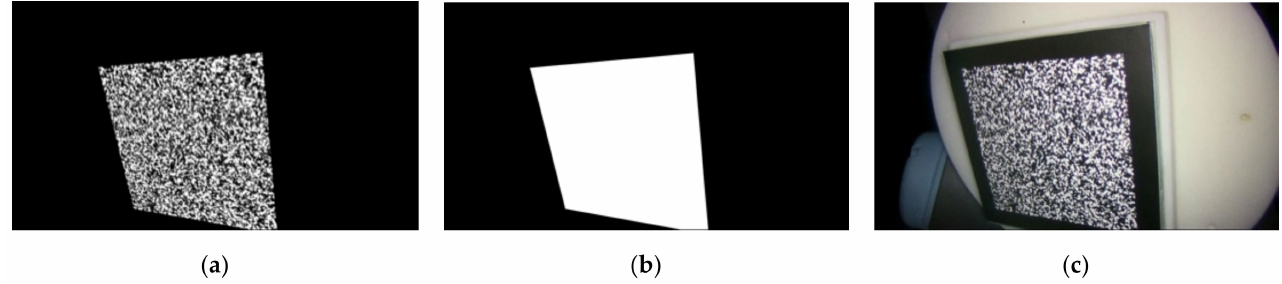
Figure 6. A group of images for DIC calculation in the second stage of our method, containing: ( a ) reprojection of reference image; ( b ) projection of mask; ( c ) image taken by the